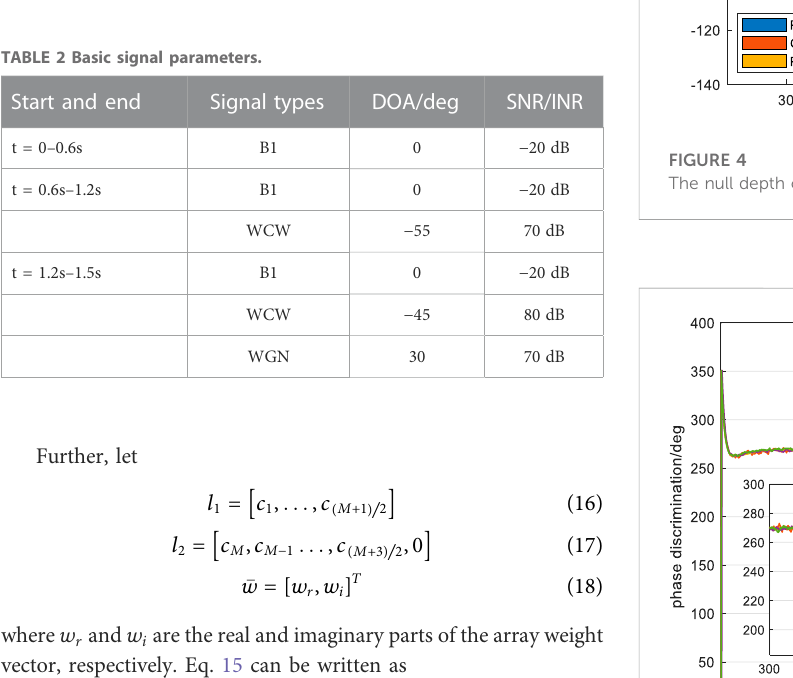
FIGURE 3 The modi fi ed STAP equivalent fi lter structure.